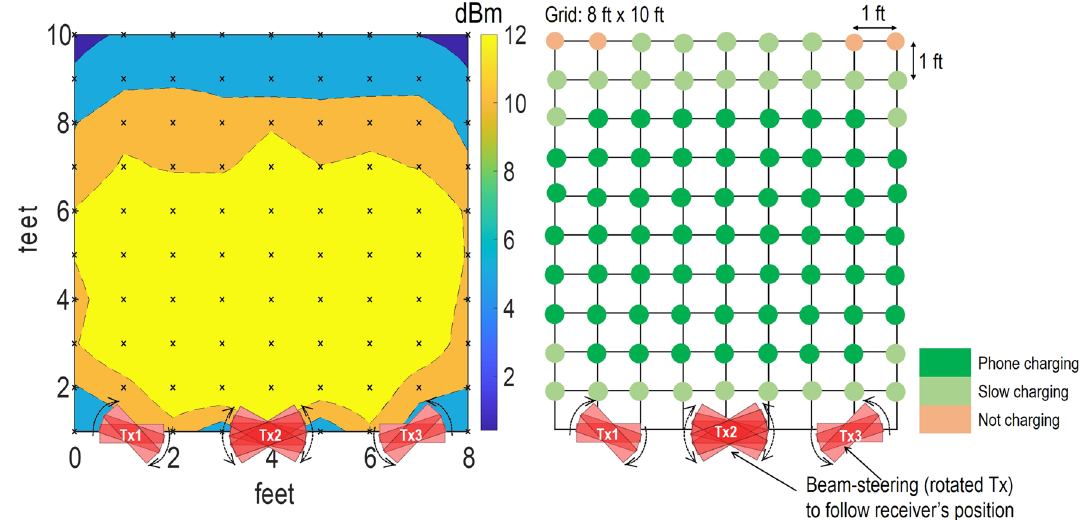
Figure 9. Power grid’s power distribution with transmitters having beam-steering capabilities. Plot generated using Matlab R2019b available at https:// mathw orks. com. Grid drawing is created using MS-PowerPoint